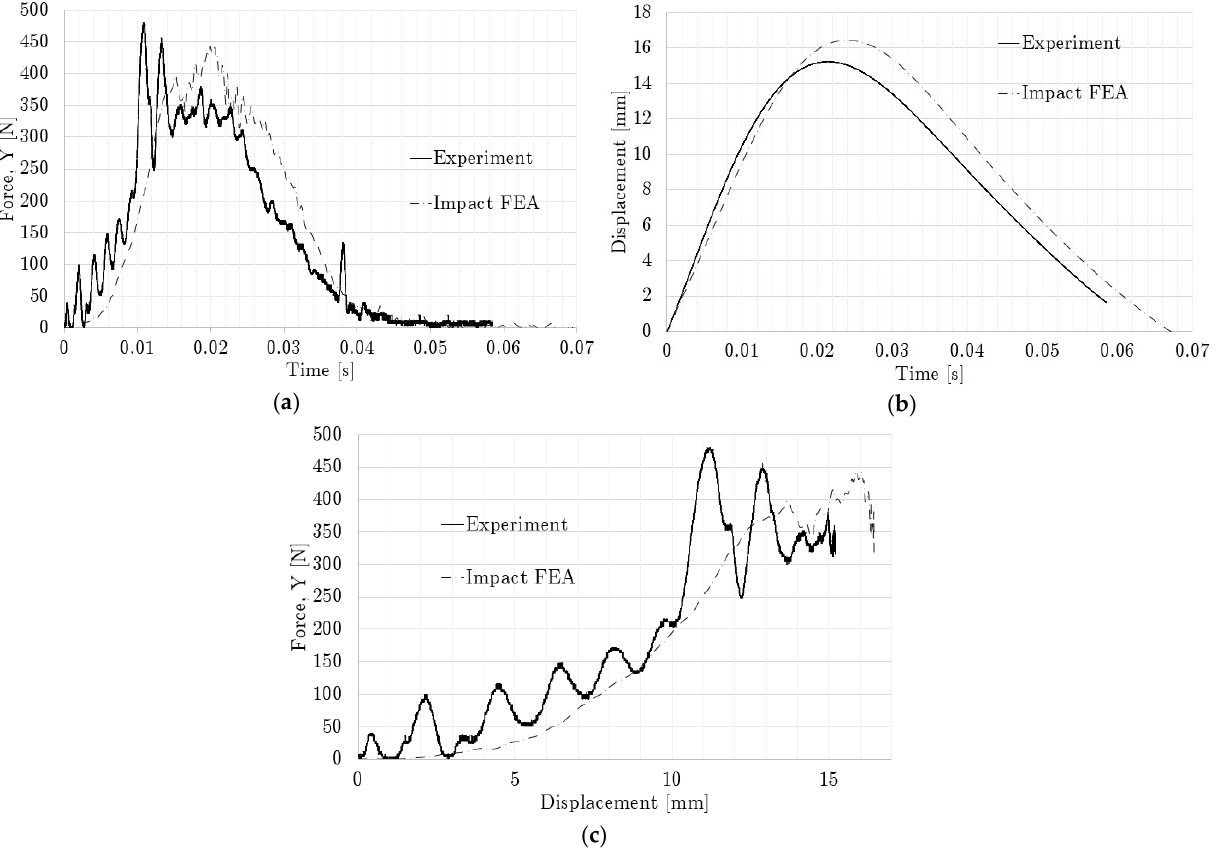
Figure 12. Impact loading comparison for side-graded lattice: ( a ) Force history, ( b ) Displacement history, and ( c ) Force–displacement curve.